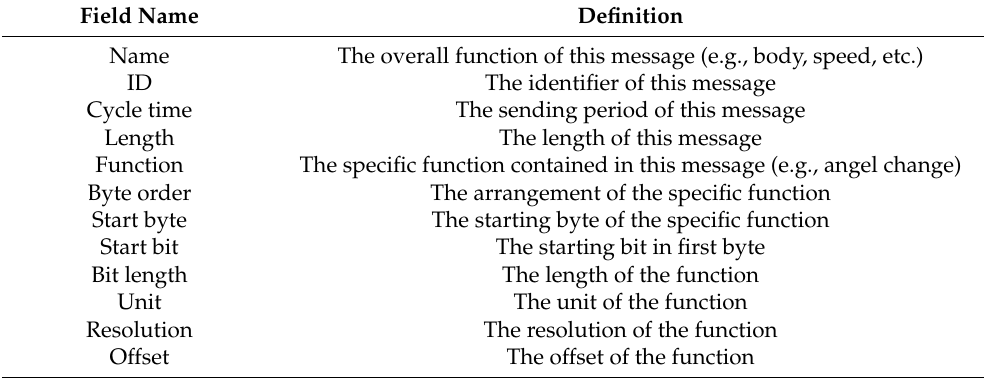
Table 1. DBC file content definition